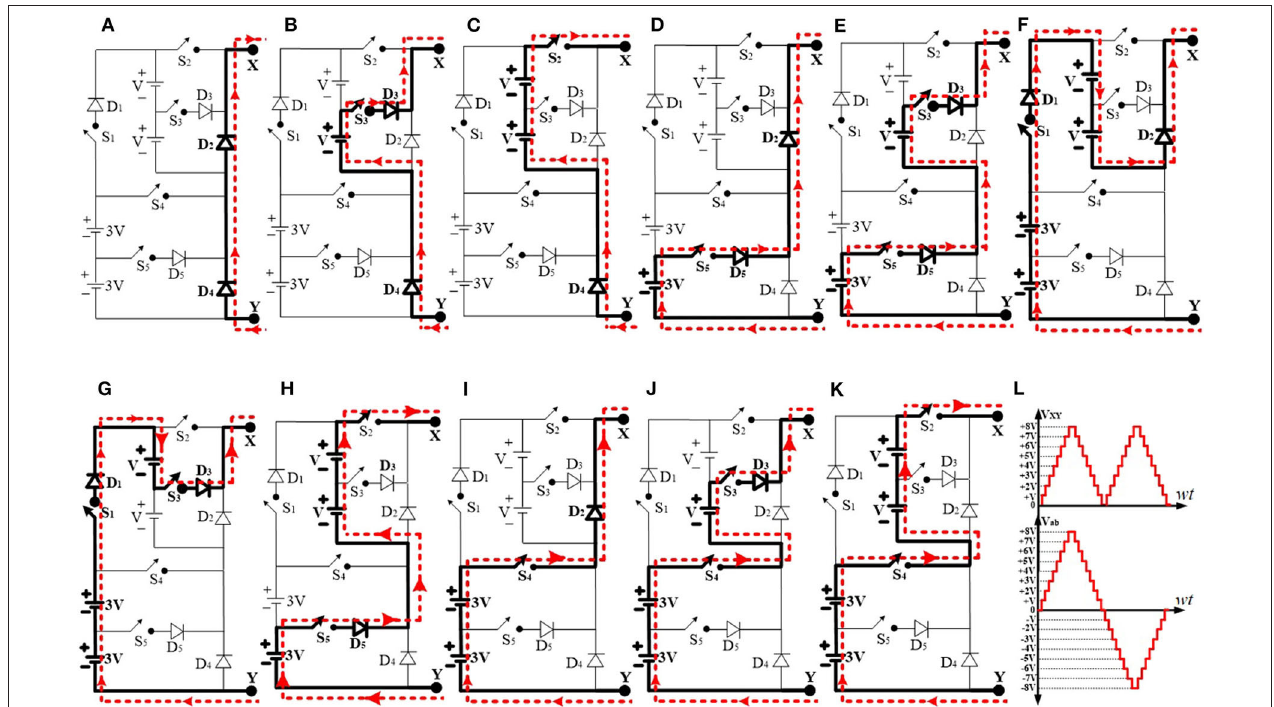
FIGURE 3 | The all possible voltage levels of the level generation circuit: (A) V XY = 0; (B) V XY = + V; (C) V XY = + 2V; (D) V XY = + 3V; (E) V XY = + 4V; (F) V XY = + 4V; (G) V XY = + 5V; (H) V XY = + 5V; (I) V XY = + 6V; (J) V XY = + 7V; (K) V XY = + 8V; (L) synthesis of the output voltage of the seventeen level